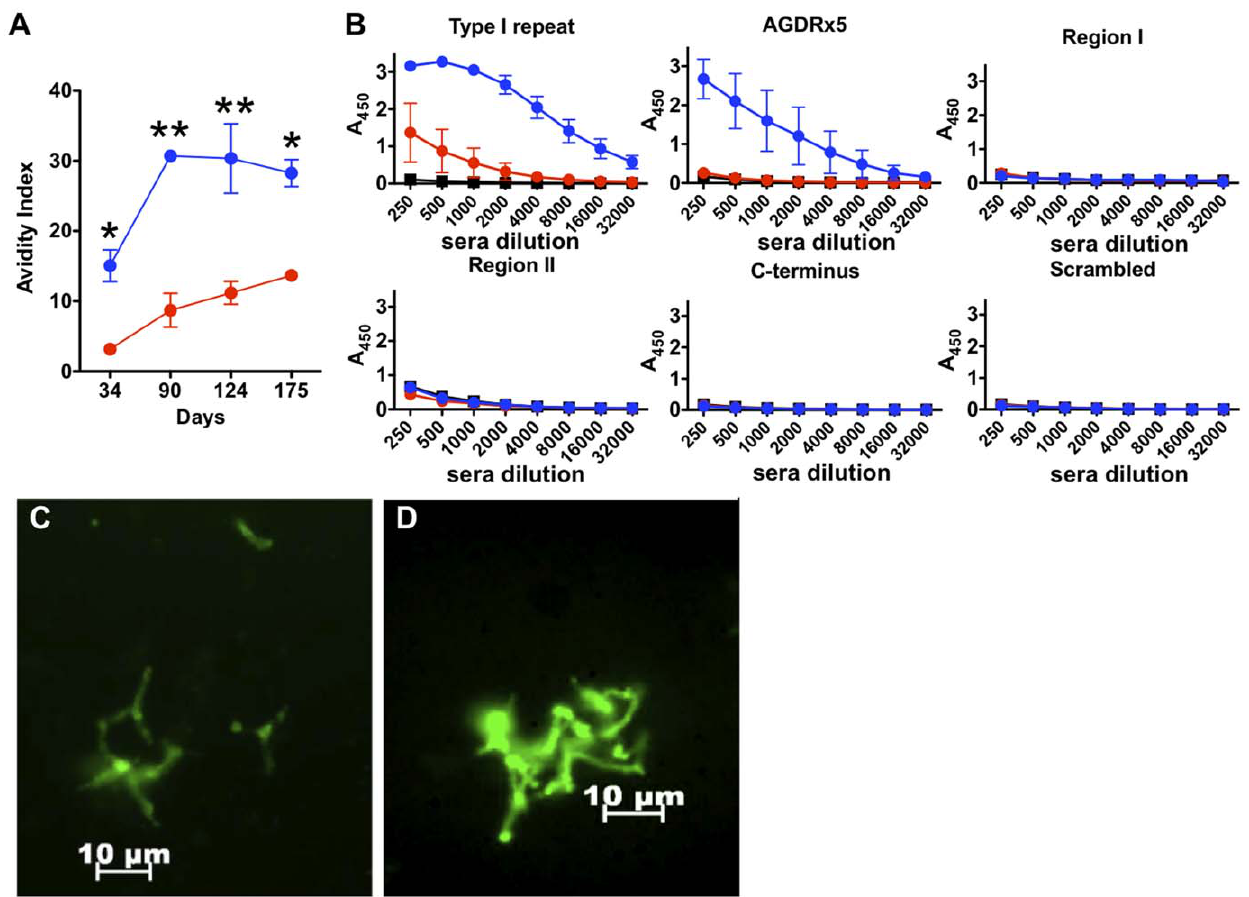
Figure 6. VMP001-NP immunization elicits high avidity antibodies capable of agglutinating live sporozoites. (A) Avidity indices of anti- VMP001 IgG sera obtained from mice immunized as in Fig. 3 with soluble VMP001 + MPLA (red circles) or VMP001-NP + MPLA (blue circles) were characterized over 6 months following vaccination. *, p , 0.01 and **, p , 0.001, analyzed by two-way ANOVA, followed by a Bonferroni post-test. (B) Anti-VMP001 IgG antibodies elicited with soluble VMP001 + MPLA (red circles) or VMP001-NP + MPLA (blue circles) were further examined for their affinities against key fragments of VMP001, including peptides representing the Type I repeat, AGDR motif, Region I, Region II, C-terminus, and scrambled negative peptide control. Sera from non-immunized mice were also included as controls (black squares). (C,D) Sera obtain from mice on day 63 post-immunizations with 2.5 m g VMP001 and 25 m g MPLA in either (C) soluble or (D) VMP001-NP formulations were incubated with live VK210 sporozoites, and immunoflurescence assay was performed to assess recognition of native CSP present on the surface of live sporozoites by anti- VMP001 IgG sera. Mice immunized with VMP001-NP vaccines raised sera that agglutinated live VK210 subtype of P. vivax .